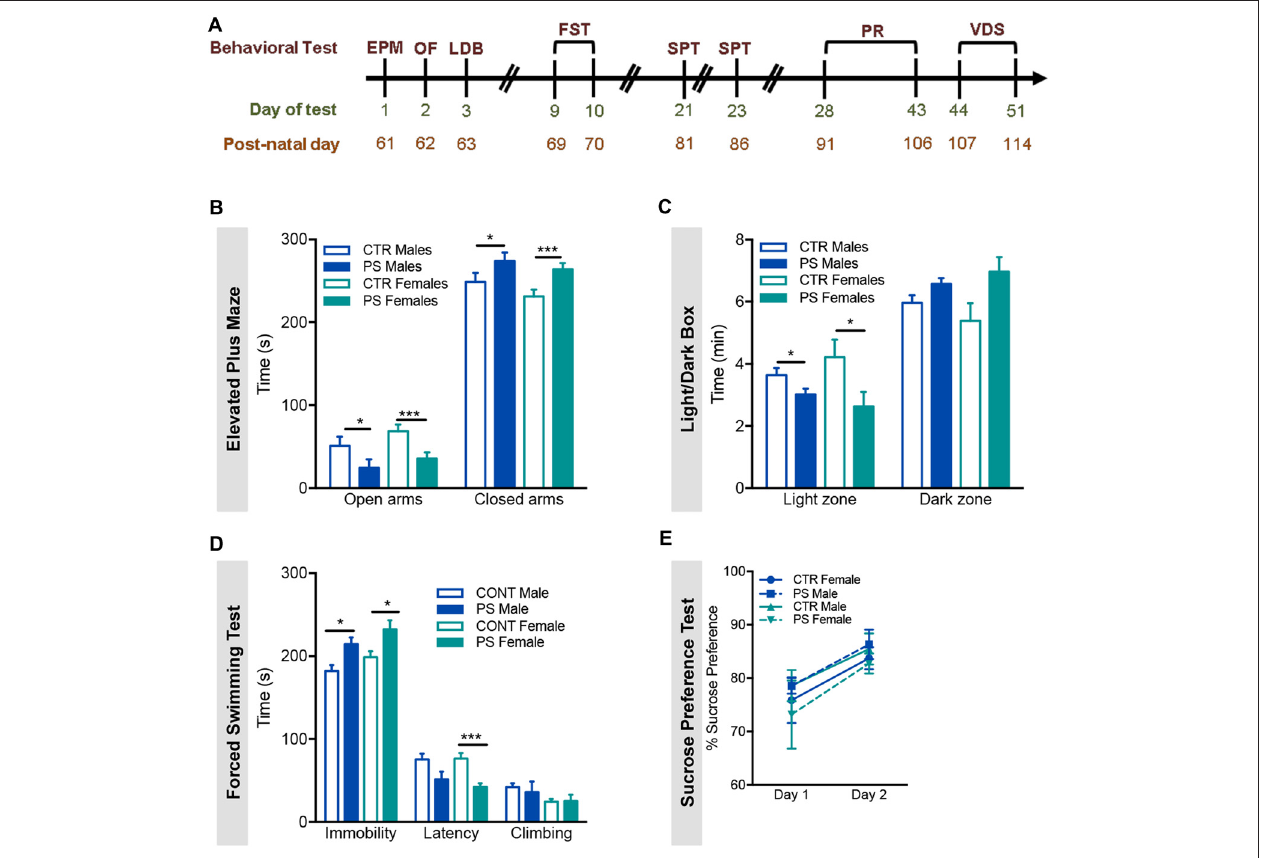
FIGURE 3 | Prenatal mild stress induces anxious- and depressive-like behaviors. (A) Timeline of the behavioral tests performed; all rats performed the same behavioral tests in the order shown; EPM, Elevated Plus Maze; OF, Open field; LDB, Light/Dark Box; FST, Forced Swimming Test; SPT, Sucrose Preference Test; PR, Progressive Ratio; VDS, Variable Delay to Signal. (B) In the EPM, PS male and female rats exhibited a decrease in time spent in the open arms of the maze, when compared with control group (n PS males = 9, n CTR males = 9, n PS females = 11, n CTR females = 12), indicative of anxious behavior. (C) In agreement with an anxious phenotype, in the LDB test, PS male and female rats spent significantly less time in the light zone, when compared with same-sex CTR (n PS males = 11, n CTR males = 9, n PS females = 8, n CTR females = 7). (D) In the FST, PS male and female rats present increased immobility time and decreased latency to immobility and climbing attempts (n PS males = 11, n CTR males = 9, n PS females = 12, n CTR females = 12), a measure of behavioral despair, and suggestive of depressive-like behavior. (E) No major differences in SPT were found (n PS males = 8, n CTR males = 8, n PS females = 12, n CTR females = 12). This test evaluates anhedonia, another dimension of